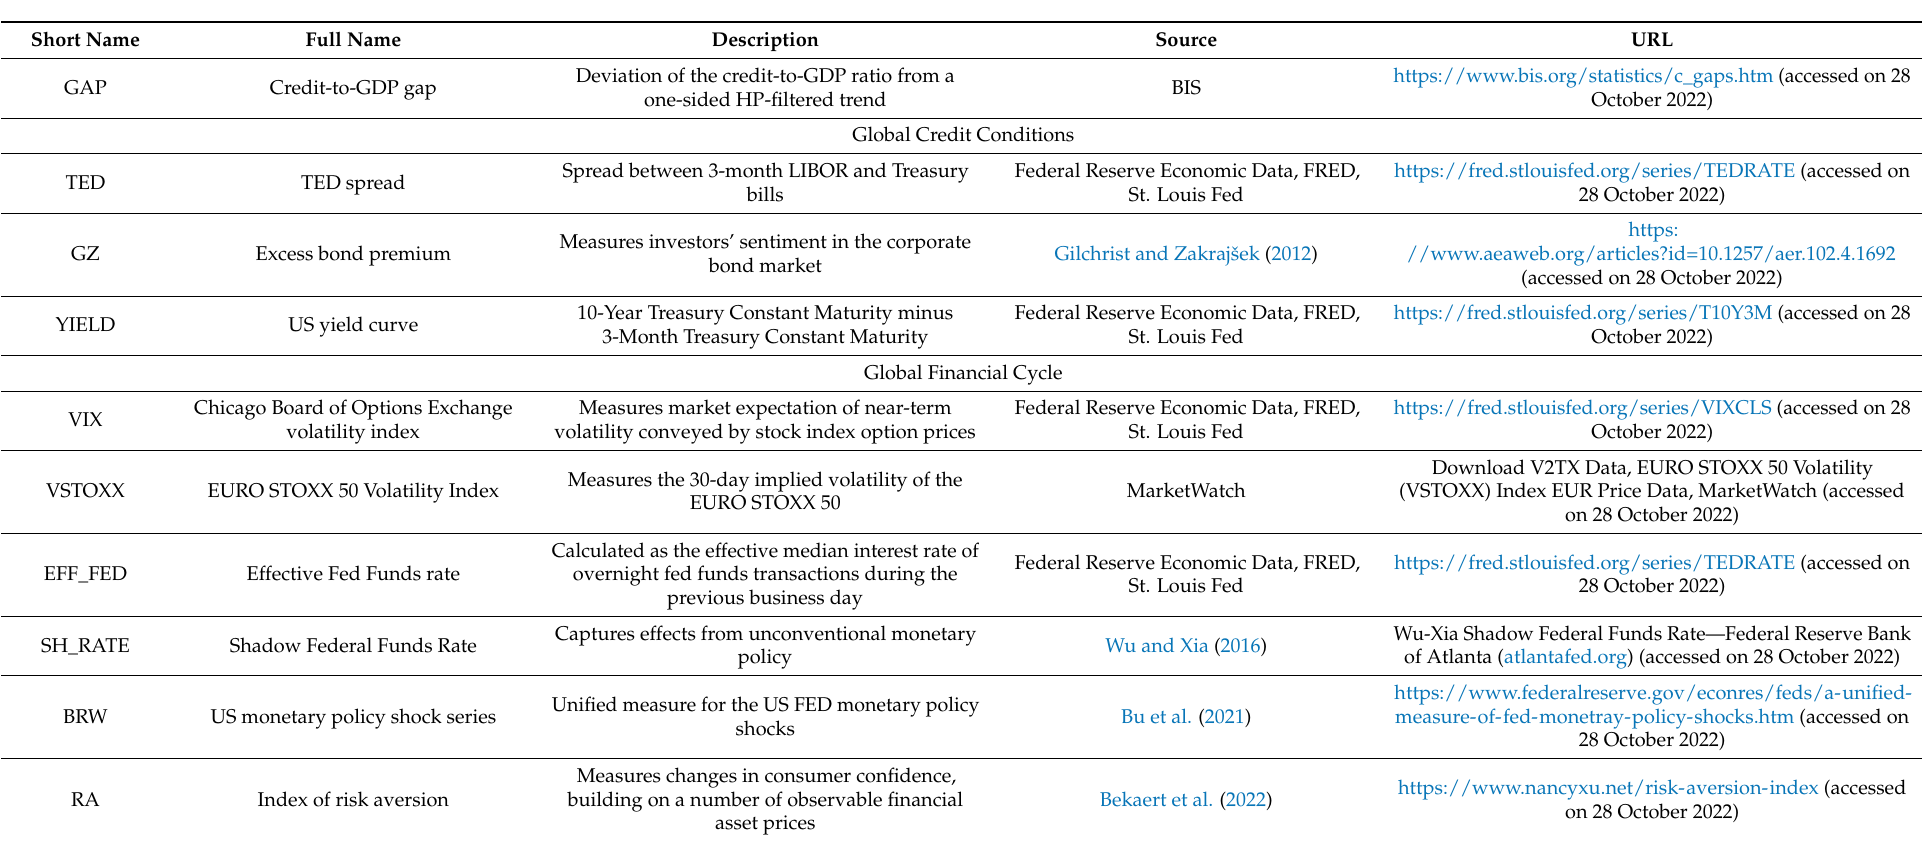
Table A1. List of